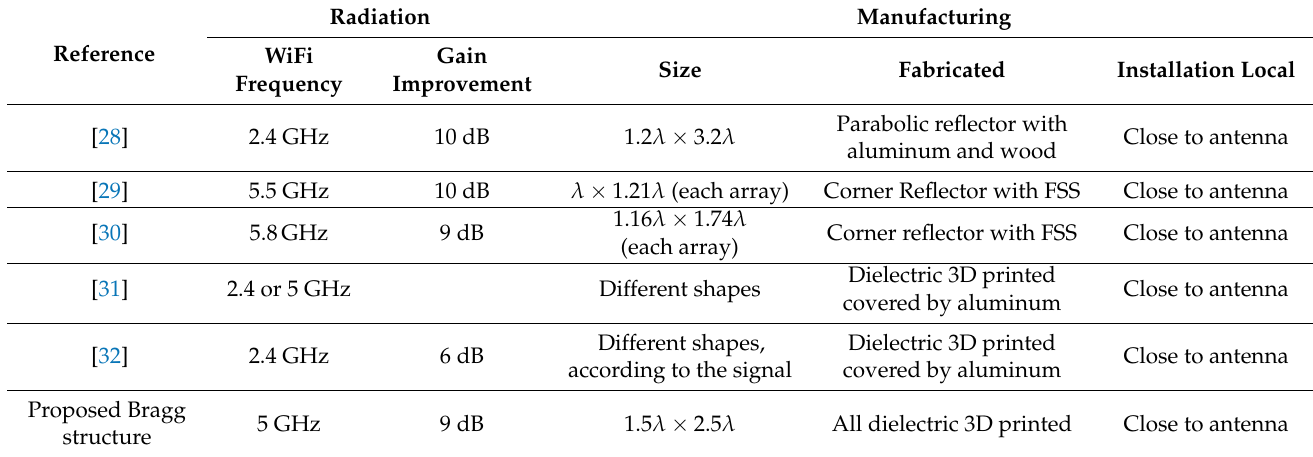
Table 1. Comparison of the performance of the proposed reflector with other structures found in the